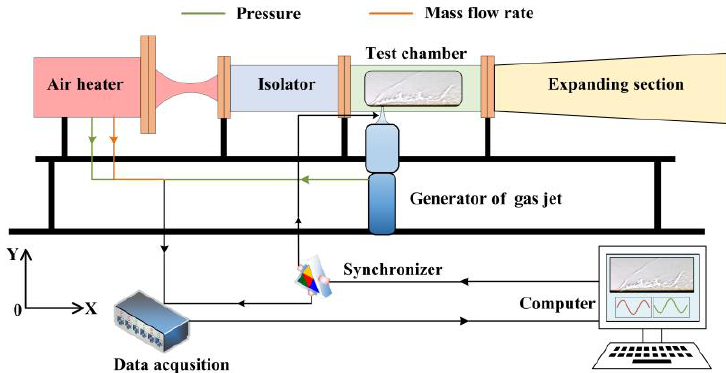
Figure 2. Schematic of the direct-connect experimental setup. The test simulated a flight condition with Mach number of 6 and altitude of 25 km.